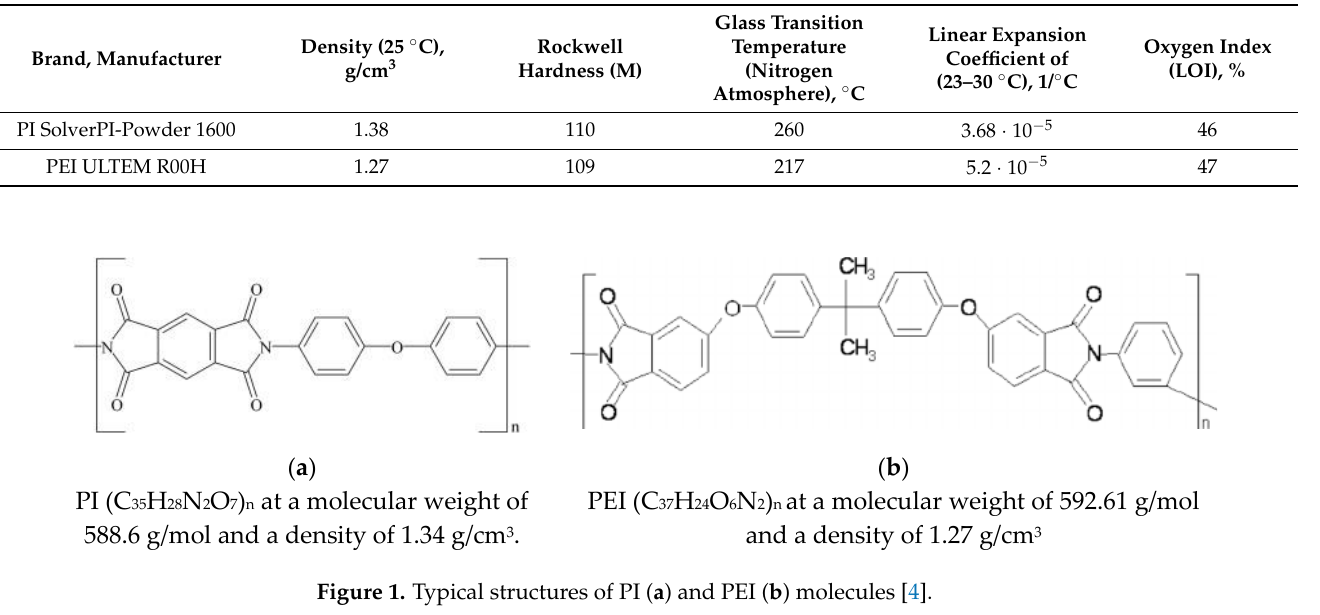
Table 1. Key physical and chemical properties of PI and PEI.